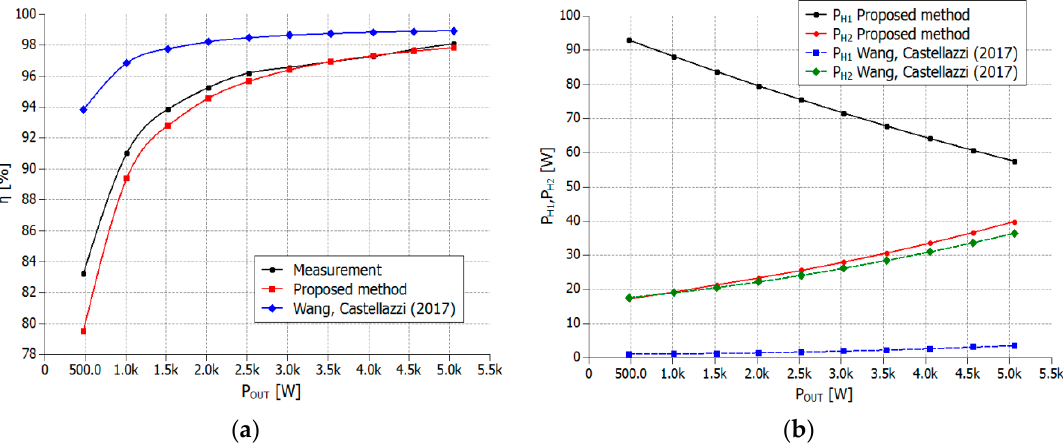
Figure 20. Comparison of the results obtained using the proposed method and approach presented by Wang and Castellazzi in [19]: ( a ) estimated and measured energy efficiency characteristics of the tested DAB converter; ( b ) power loss characteristics of bridges H 1 and H 2 .